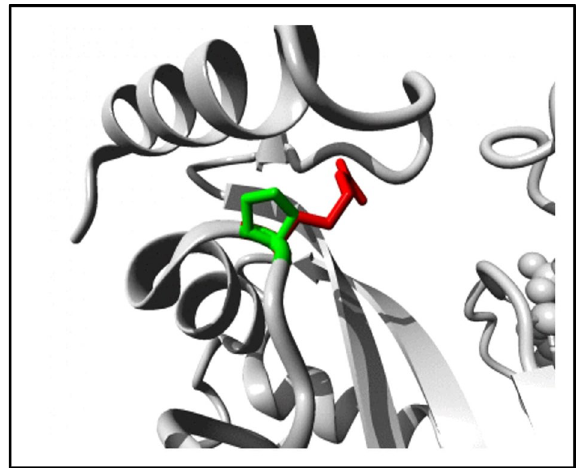
Figure 4. Structural alteration of the wild type residue P350 by the mutant R350 illustrated by Project Hope. The wild type residue is presented as green and the mutant residue is shown in